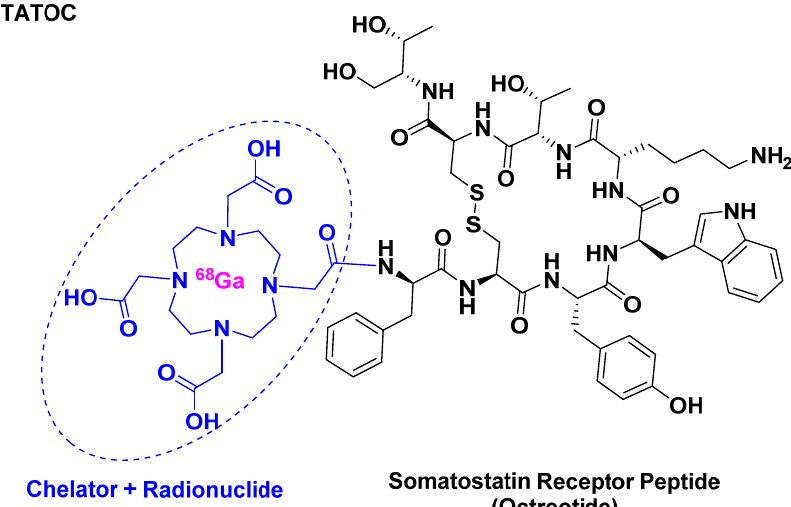
Figure 4. Chemical structure of 68 Ga-DOTATOC.